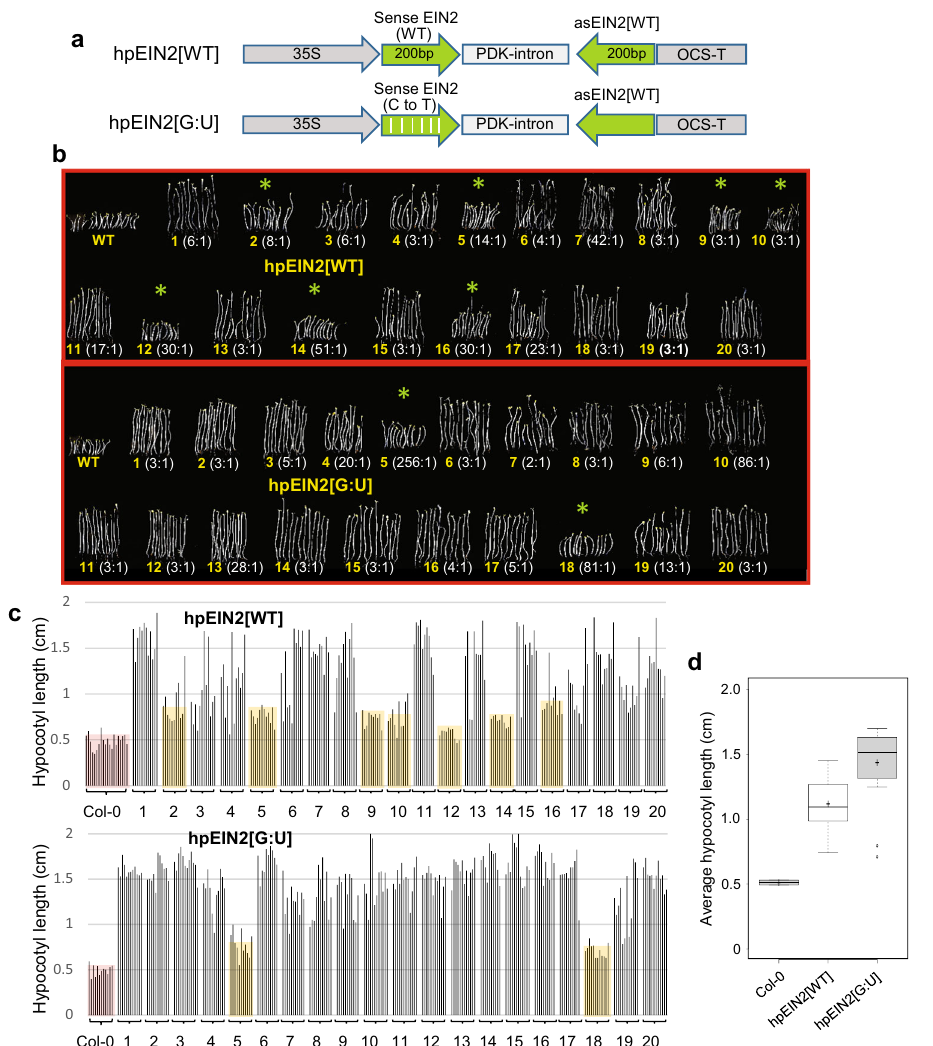
Fig. 2 G:U modi fi ed hpRNA construct induces uniform RNAi of the endogenous EIN2 gene in Arabidopsis. a Schematic of the traditional (hpEIN2[WT]) and the G:U modi fi ed (hpEIN2[G:U] constructs. b Hypocotyl length phenotypes of 20 independent lines each of the two constructs, with longer hypocotyls indicating stronger EIN2 RNAi. Approximately 12 T2 siblings with representative hypocotyl lengths were placed side by side and photographed. Untransformed (WT) Arabidopsis Col-0 plants were used as control. The kanamycin resistant:sensitive plant ratio for each line is shown in the bracket. c Measured lengths of the plants shown in ( b ). Plant lines with weak EIN2 RNAi are highlighted with yellow shading. d Box plot (BoxPlotR, http:// shiny.chemgrid.org/boxplotr/) of average hypocotyl lengths of the 20 independent hpEIN2[WT] and hpEIN2[G:U] lines in ( b ) and ( c ). Each data point corresponds to the average length of around 10~12 T2 siblings of an individual line ( n = 20). For the WT Col-0 control, there are two data points ( n = 2) containing 20 and 12 seedlings. The central horizontal line indicates the median value; the lower and upper borders of the box represent the fi rst and third quartiles; whiskers extend 1.5 times the interquartile range from the fi rst and third quartiles; outliers are represented by dots; crosses represent sample means. Source data are provided as a Source Data fi